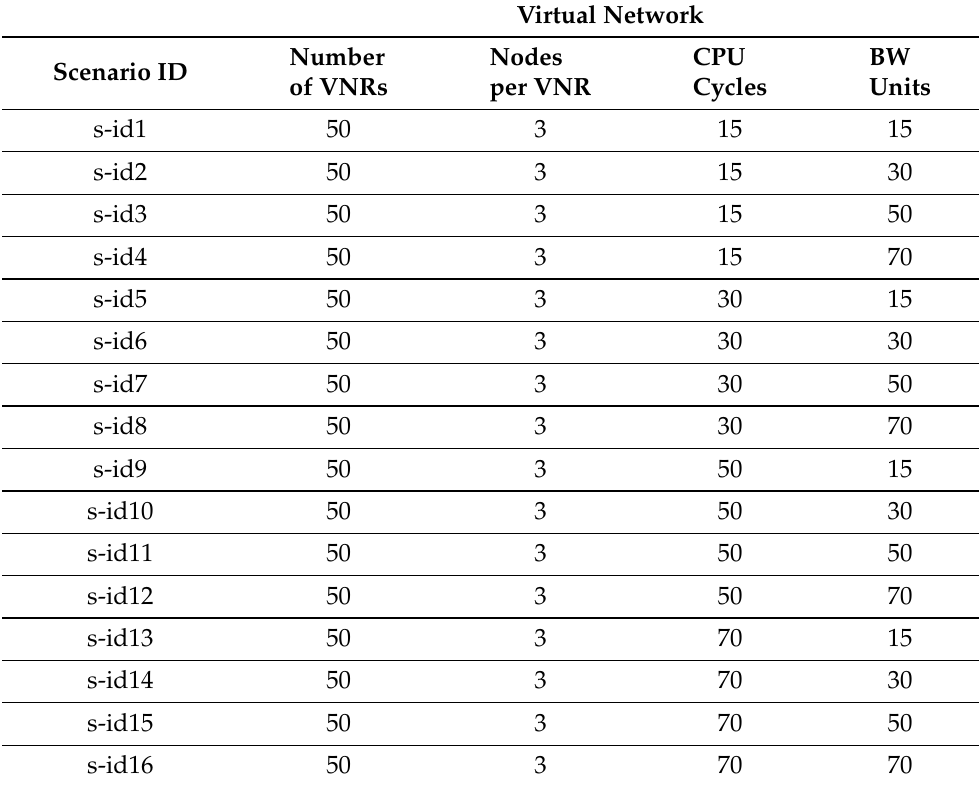
Table 4. The many–small parameter